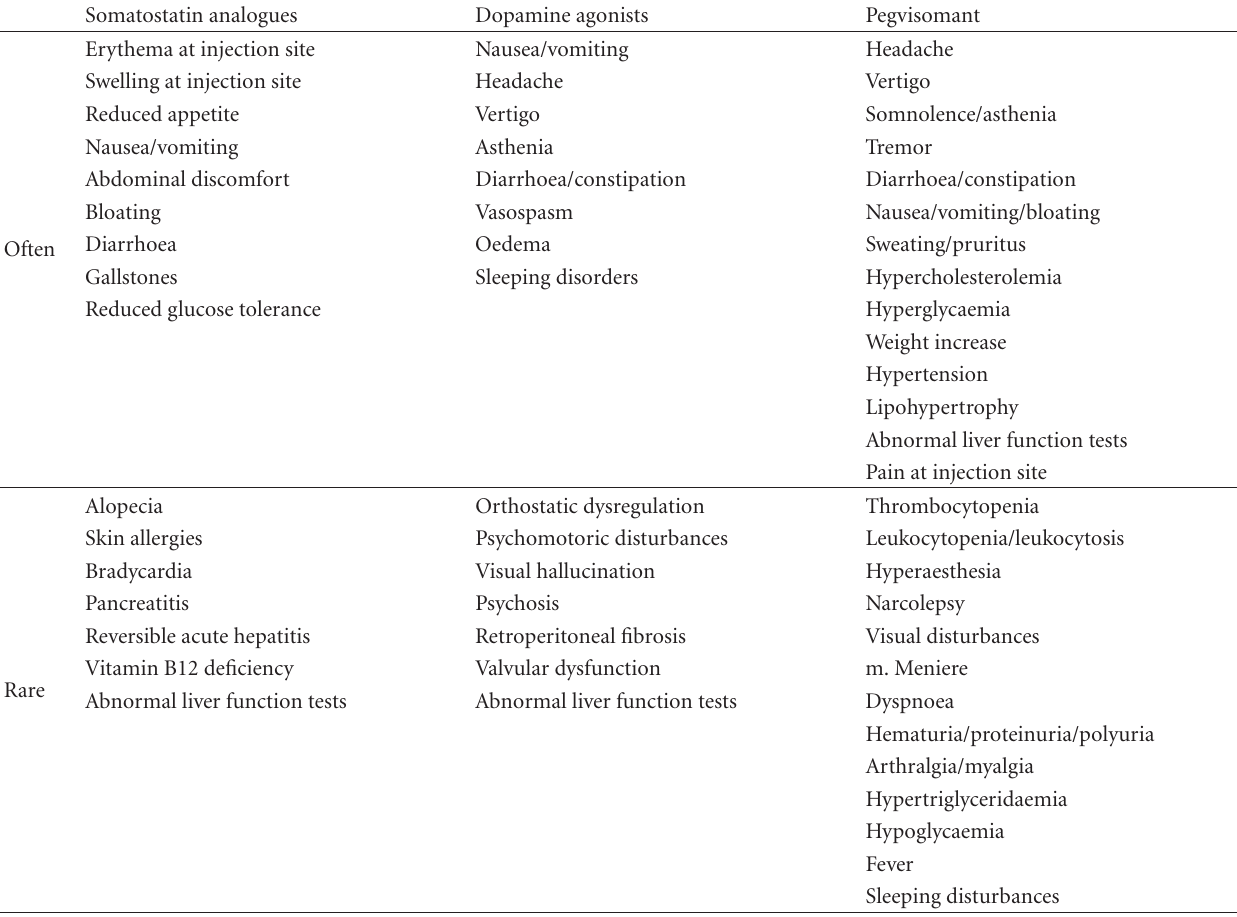
Table 2: Side-e ff ects.